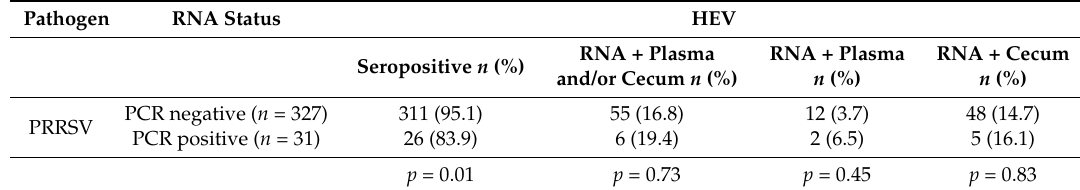
Table 3. Association with porcine reproductive and respiratory syndrome virus (PRRSV) active infection (RNA detection in tonsil) (from 358 animals where PCR results for both PRRSV and hepatitis E virus (HEV) were